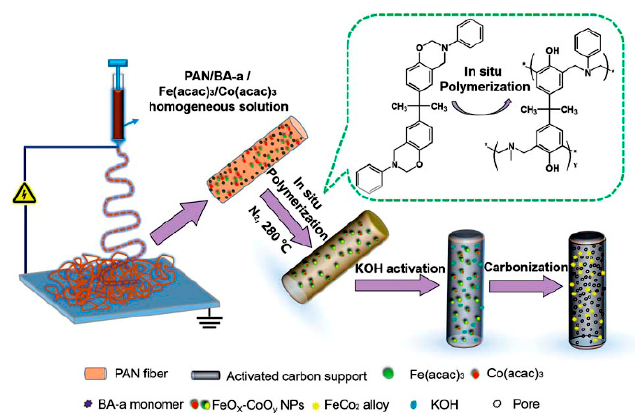
Figure 13. Scheme of FeCO 2 crystals supported on nitrogen-doped porous carbon fibers (Reproduced with permission from [81]. Copyright The Royal Society of Chemistry, 2017).